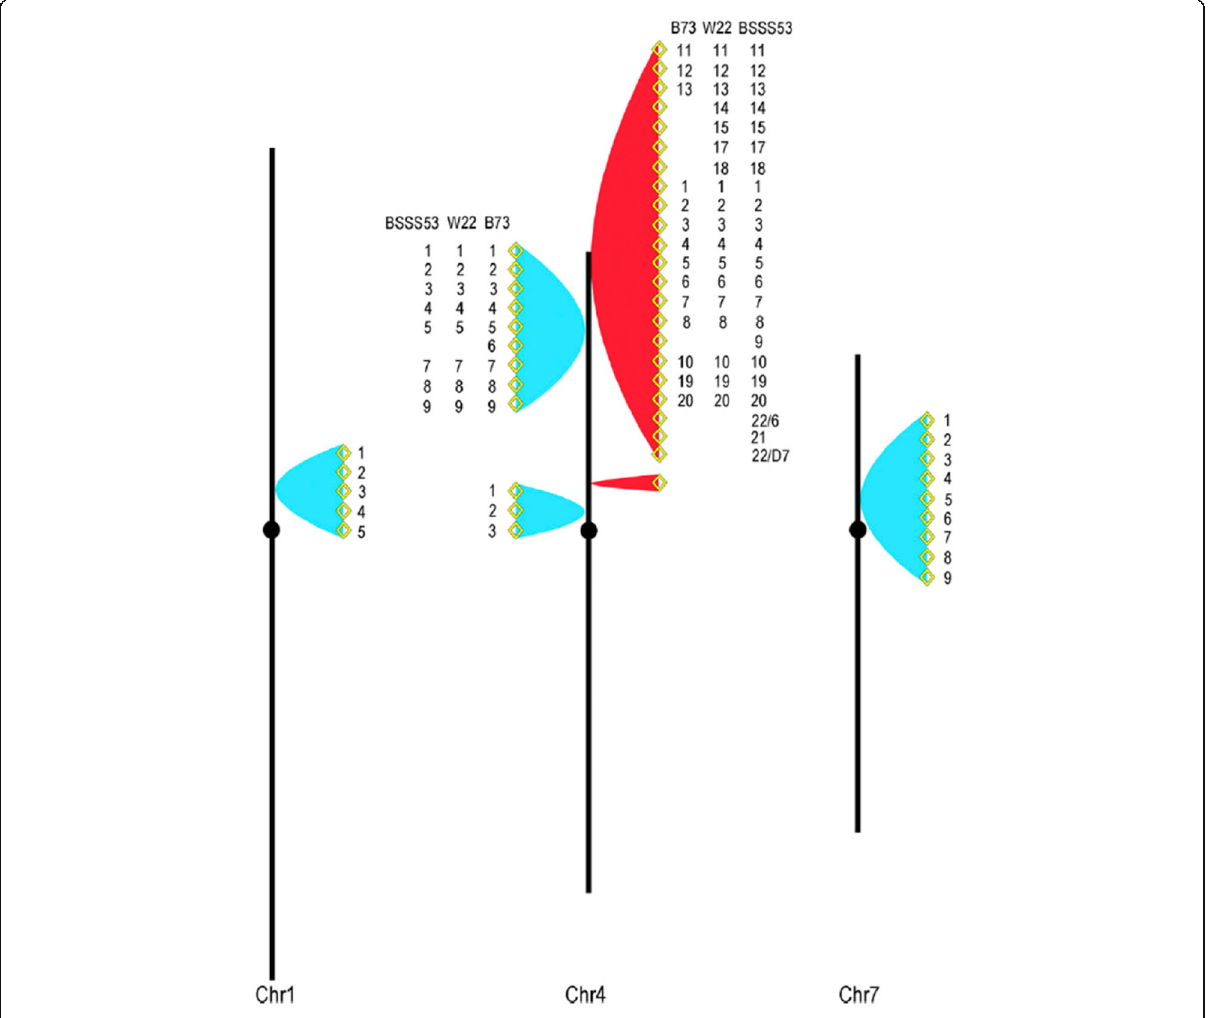
Fig. 3 Genomic distribution of α -zein loci in three maize inbred lines. Zein gene copies at each locus in the genome are presented as yellow diamonds on a blue (19-kDa clusters) or red (22-kDa clusters) background. When copy number differs between three inbreds, the zeins are numbered accordingly. Vertical bars represent maize chromosomes, from left to right, chromosome 1, chromosome 4, and chromosome 7 (Taken from Dong et al.